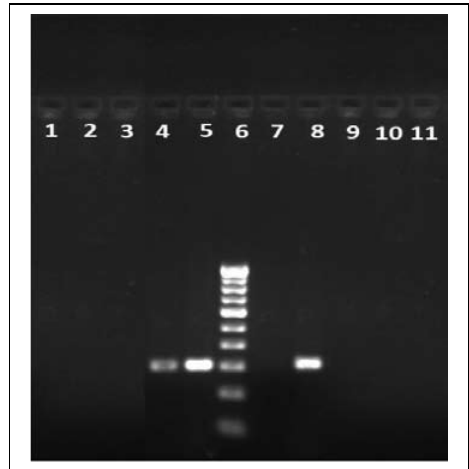
Fig. 1. Agarose gel electrophoresis of 23S rRNA specific PCR of S. aureus (Lane 1: Positive control, Lane 6:Negative control Lane 2,4,5,7,8: Positive samples (1318 bp),Lane 3:DNA Marker (100